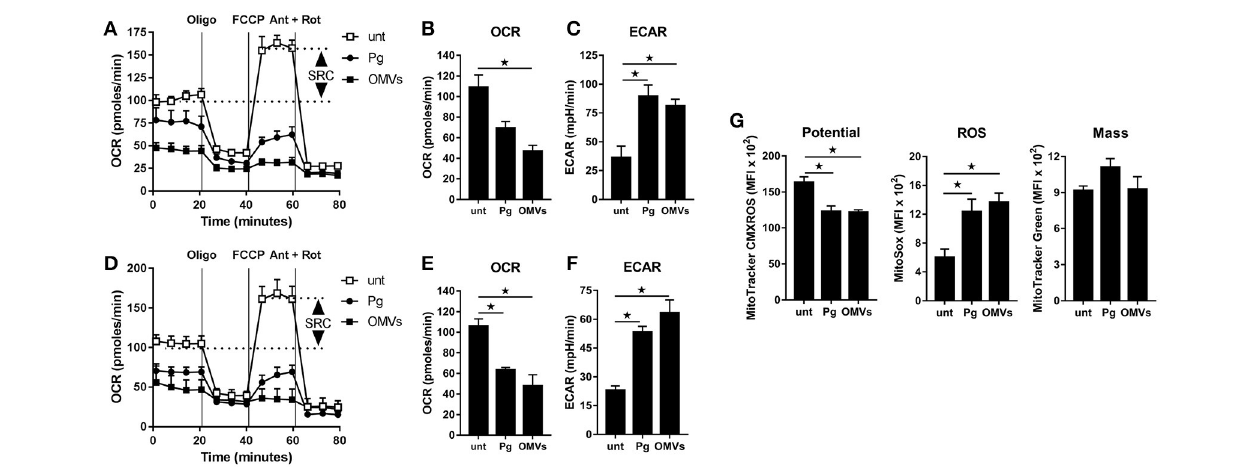
FIGURE 3 | P. gingivalis and its OMVs disrupt mitochondrial respiration in macrophages. The mitochondrial respiration of BMM (A–C) and MDM (D–F) following infection with P. gingivalis ( Pg ) or OMVs (2 h at MOI of 25:1, see Materials and Methods) measured in a Seahorse XF-24 analyzer after 24 h. (A,D) Real-time oxygen consumption (OCR) was determined during sequential treatments with oligomycin (ATP-synthase inhibitor), FCCP, and antimycin-A + rotenone (ETC inhibitors) over 80 min. Spare respiratory capacity (SRC), the difference between maximal OCR, and the basal OCR, is depicted in the plots. Data represent means ± SD of triplicates. One of three experiments is shown. Basal OCR (B,E) and extracellular acidification rate (ECAR) (C,F) were analyzed (at 24 h) as readouts for oxidative phosphorylation (OXPHOS) and glycolysis, respectively. Data are mean ± SD from three independent experiments. (G) Mitochondrial membrane potential, ROS production and mass were determined at 24 h in BMM (treated as in A ) by flow cytometry after staining with MitoTracker CMXROS, MitoSOX Red and MitoTracker Green FM, respectively. Data are mean fluorescence intensity (MFI) ± SD from three independent experiments (* p <